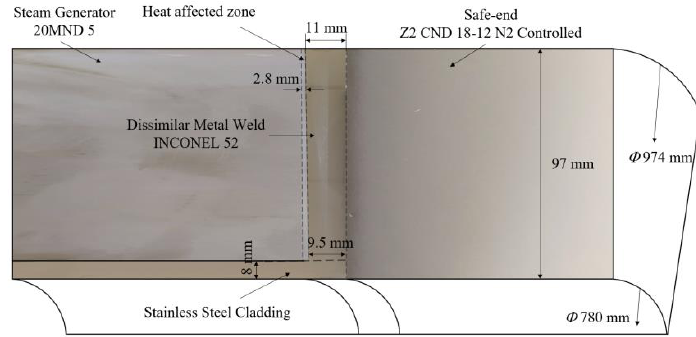
Figure 2. The size and configuration of the weld joint. Table 1. Chemical composition of the BMs and WM of the DMW joint (%).